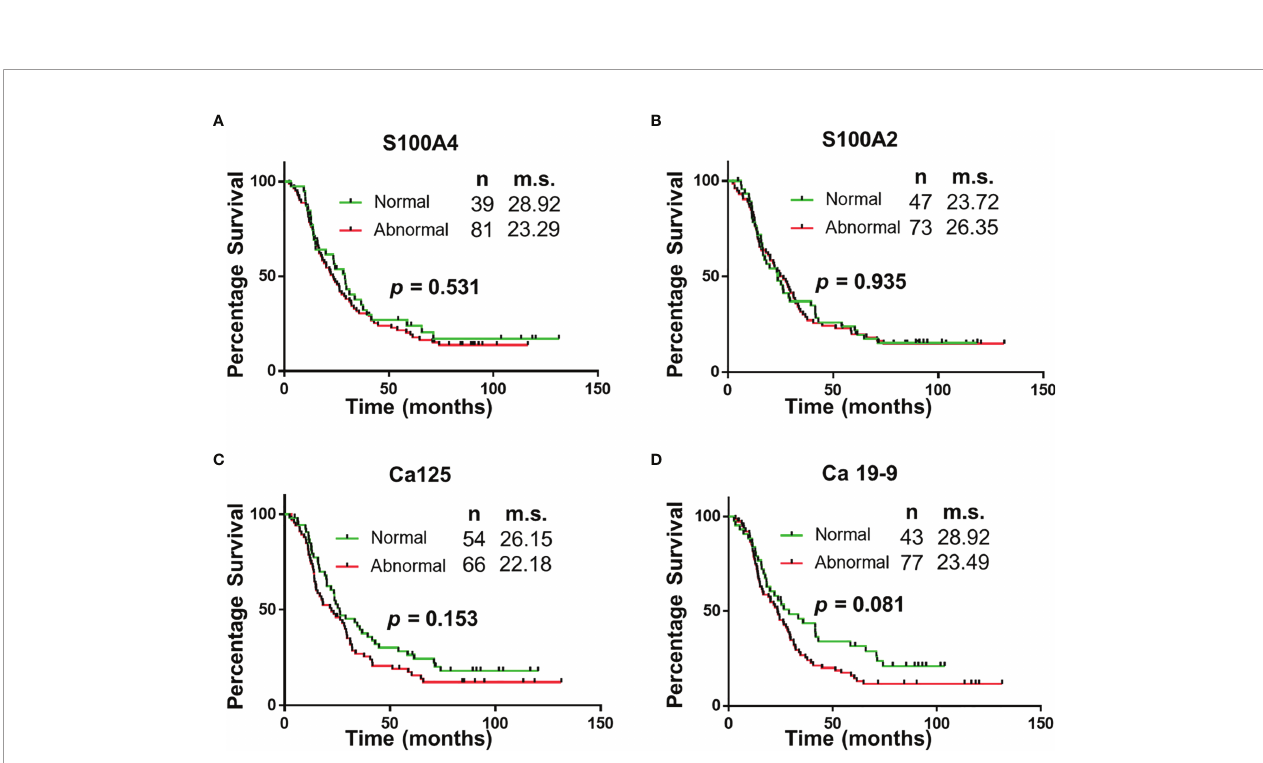
FIGURE 2 | Univariable Survival Analysis of Individual Biomarkers. (A – D) Kaplan Meier survival curves for individual biomarkers were generated using prognostic cut- offs ( Supplementary Table 3 ). n, number of patients; m.s., median survival in